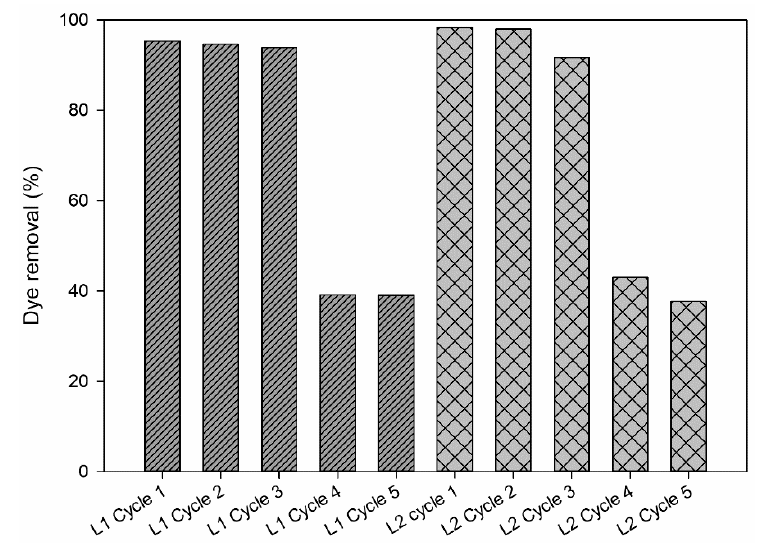
Figure 12. CR removed per cycle of APTES L1 and L2 adsorbents.